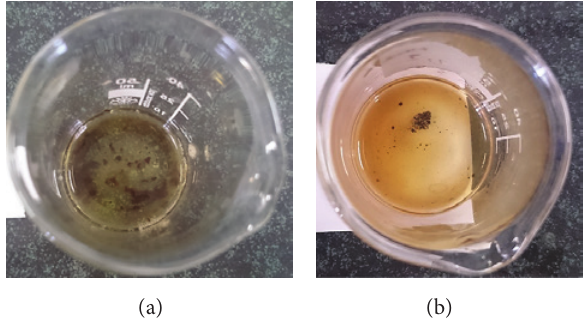
Figure 4. Nanofluid at pH = 4 (a) and pH = 11(b) For optimizing pH, 1.5 g of soil was washed with 15 mL of 500 ppm nanofluid at pHs, including, 5 through 10, for 24 hr. The results are shown in Figure 5.